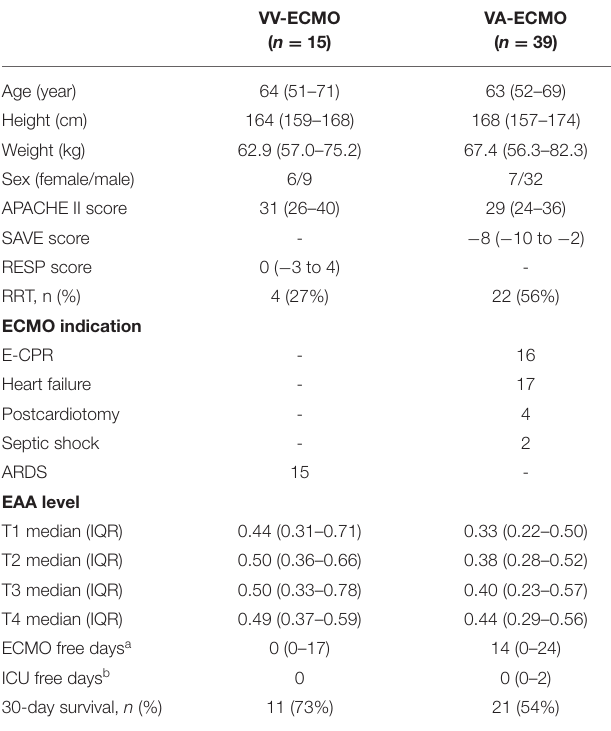
TABLE 1 | Characteristics and clinical outcomes of patients with VV-ECMO or